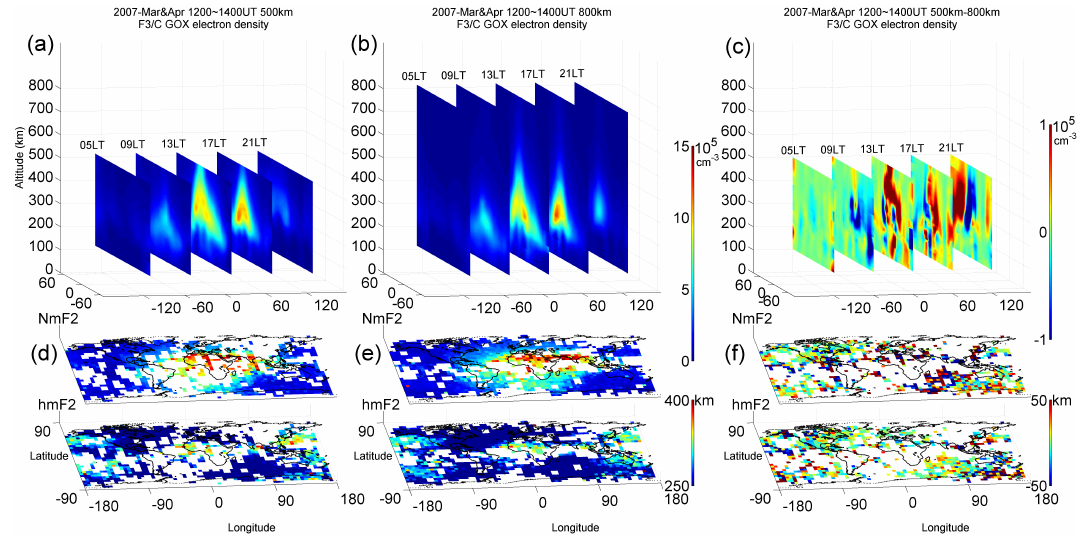
Figure 2. The F3/C electron density, Nm F2, and hm F2 observed from 500 and 800km altitude satellites, and their difference during 12:00– 14:00UT in March and April of 2007. (a) F3/C electron density observed from 500km altitude, (b) F3/C electron density observed from 800km altitude, and (c) their difference. (d) F3/C Nm F2 and hm F2 observed from 500km altitude, (e) F3/C Nm F2 and hm F2 observed from 800km altitude, and (f) their difference.